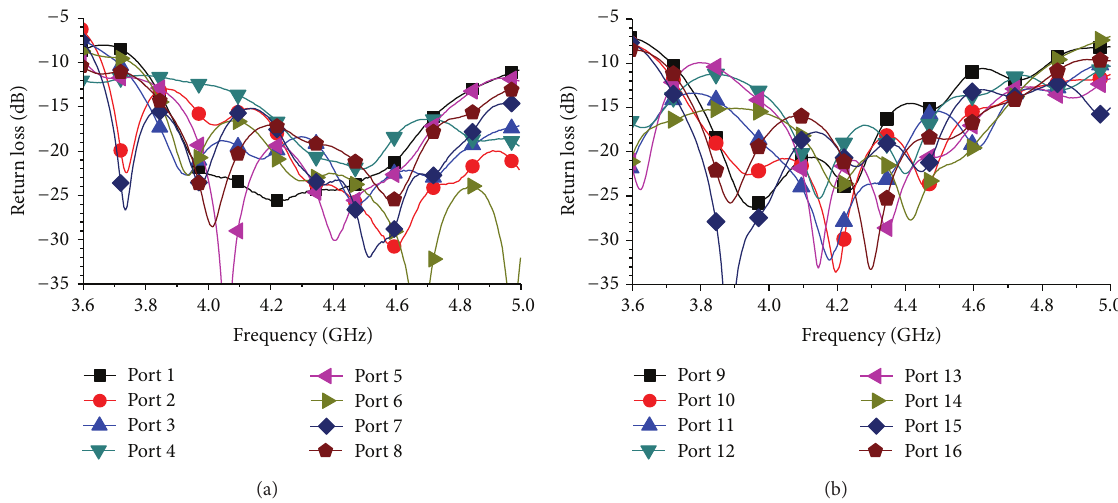
Figure 8: The measured results of return loss at input ports (a) and output ports